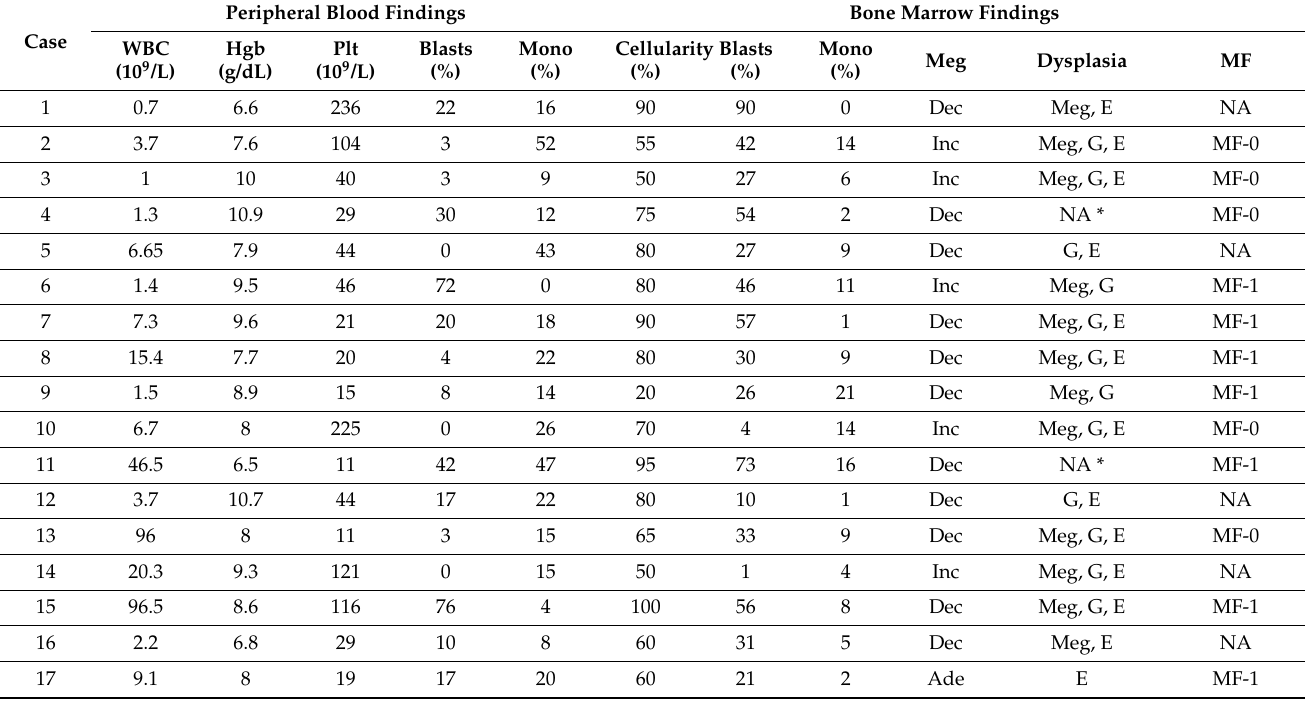
Table 2. Peripheral blood and bone marrow findings.